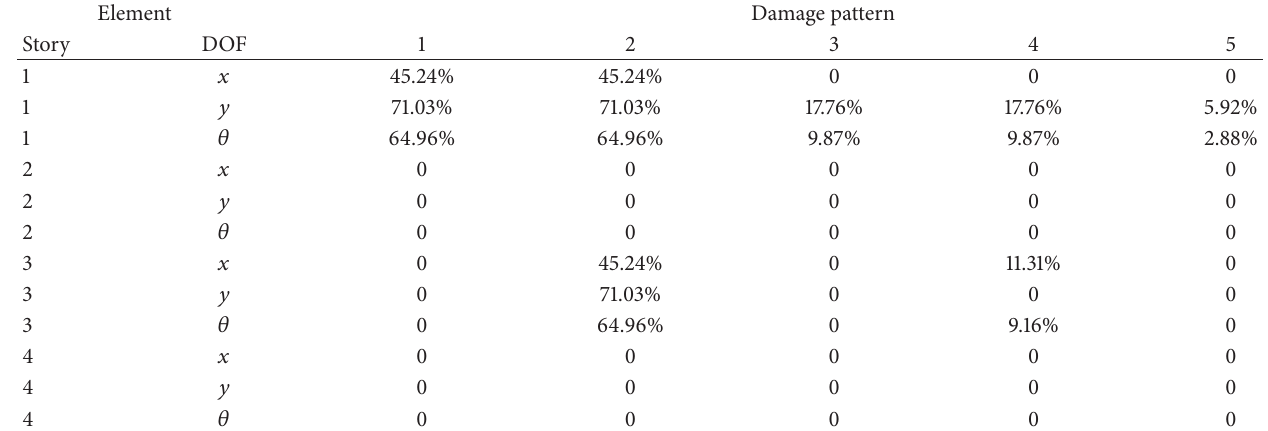
Table 4: Percentage losses in horizontal and rotational stiffness for each pattern.